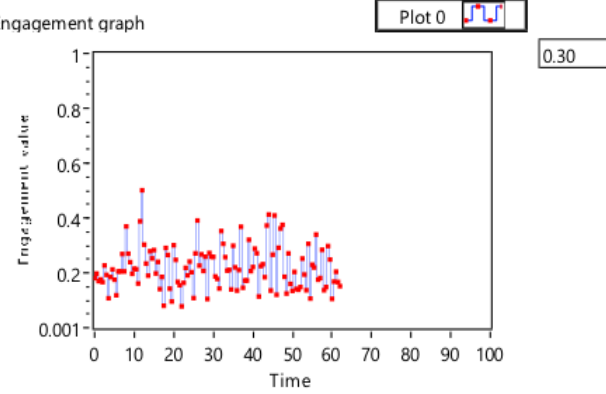
Figure 7. Engagement data for one